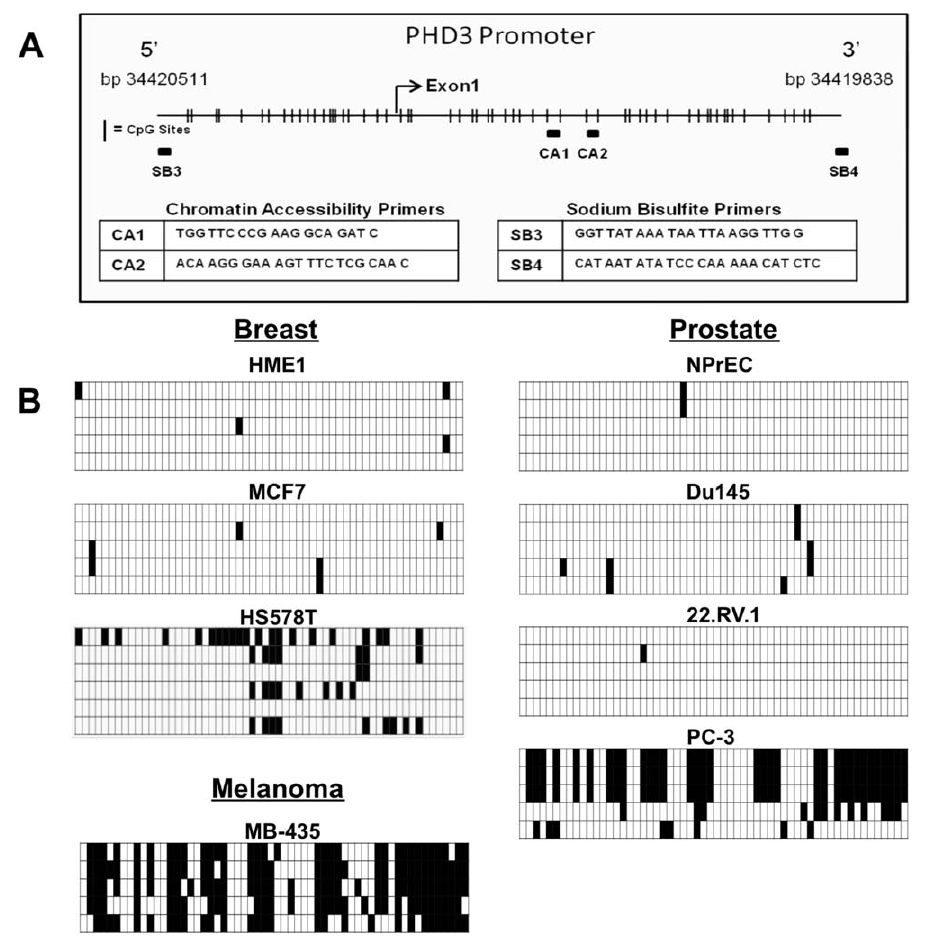
Figure 3. DNA methylation analysis of the PHD3 5 9 -CpG island in human melanoma, prostate and breast carcinoma cell lines. A ) Schematic representation of the CpG distribution in the 5 9 -regulatory region of the PHD3 gene from UCSC Genome Browser coordinates bp34420511-bp34419838. The CpG sites are represented by vertical tick marks, and the beginning of exon 1 is depicted as a bent arrow. The locations of PCR primers used to assess genomic methylation (SB3 and SB4) and chromatin accessibility (CA1 and CA2), respectively. B ) Bisulfite sequencing was performed on DNA isolated from two non-tumorigenic epithelial cell lines (NPrEC and hTERT-HME1) and six tumor cell lines (DU 145, 22RV.1, PC-3, MB-435, HS578T, and MCF7). Each grid contains at least 5 rows representing the 5 individually cloned and sequenced bisulfite PCR products from the indicated cell lines. Each row contains 58 boxes representing the 58 CpGs in an individual cloned molecule. Open and filled boxes are unmethylated and methylated CpG sites,